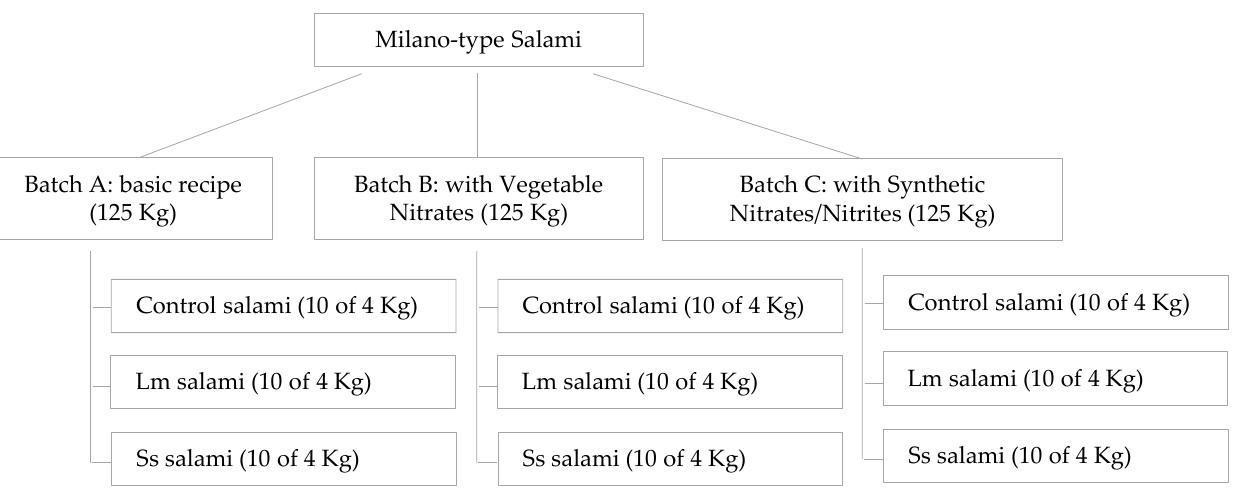
Figure 1. Graphical presentation of the experimental design.